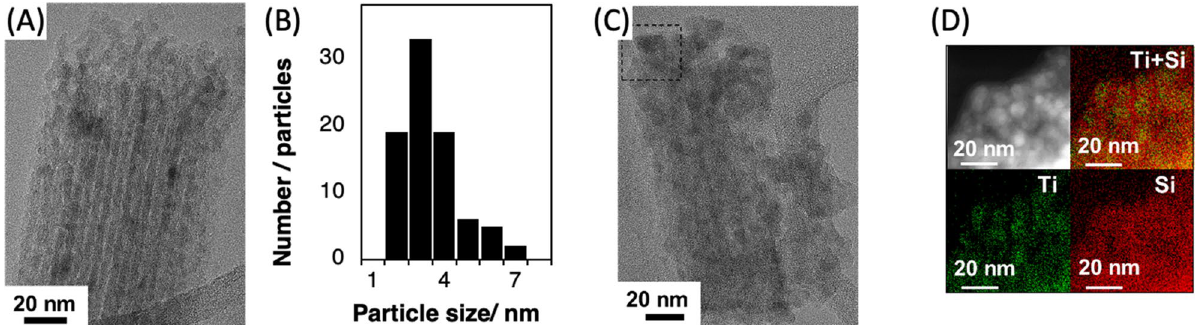
Figure 8. TEM image of ( A ) SBA-0.1TTIP-800 and ( C ) SBA-0.1TTIP-1100, ( B ) the particle size distribution of the anatase in SBA-0.1TTIP-800 derived from the TEM and EDS elemental analysis ( D ) of